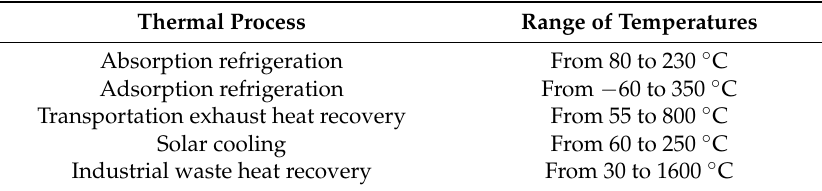
Table 1. Potential thermal energy processes which can operate under partial load operation conditions within the temperature range between 120 and 200 ◦ C. Based on Gasia et al.